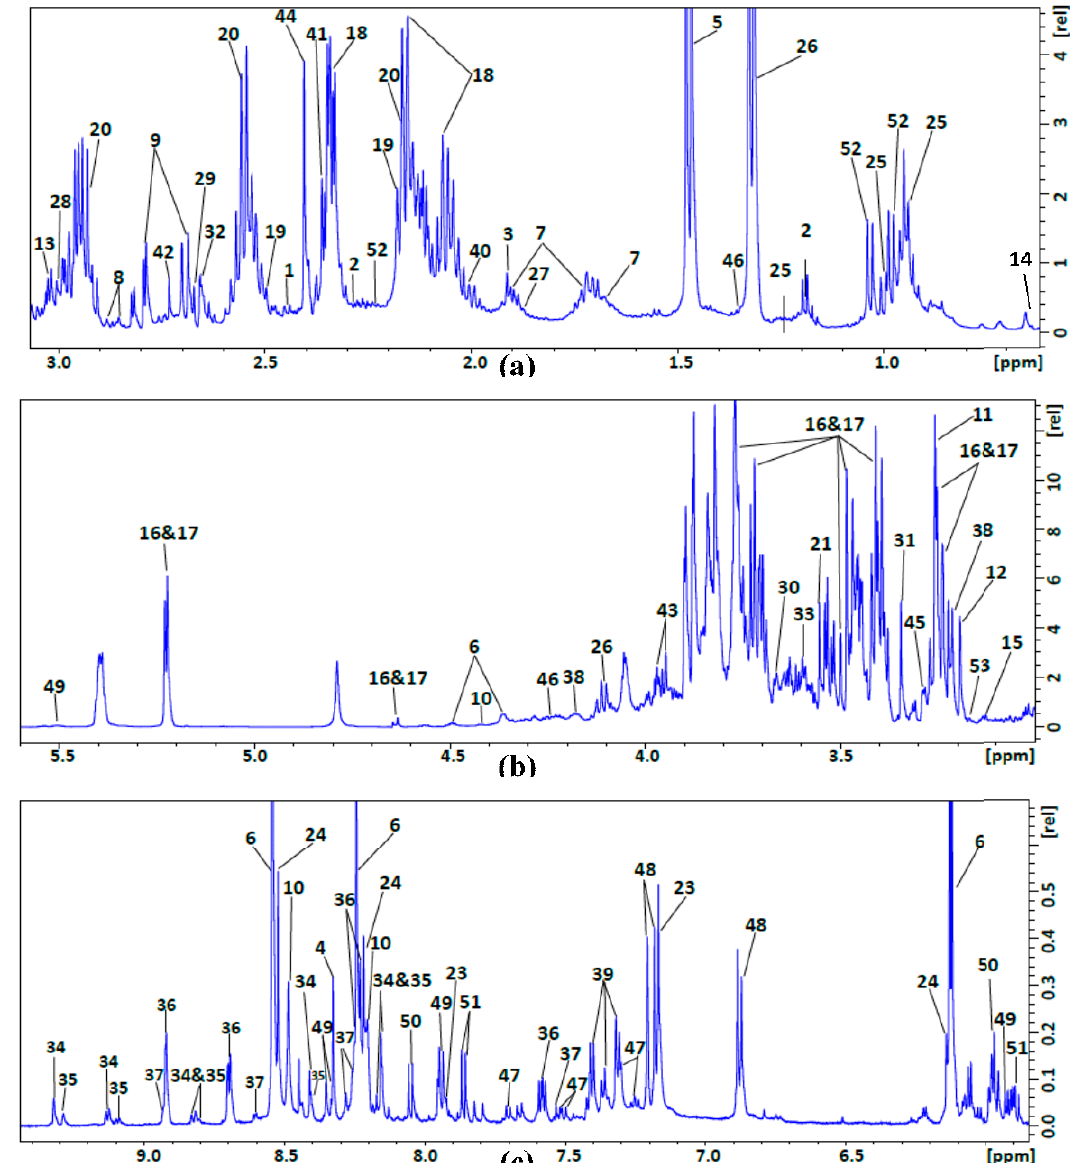
Figure 1. 1 H NMR spectra of the polar extract from avian liver. ( a , b ) Low frequency region. ( c ) High frequency region.